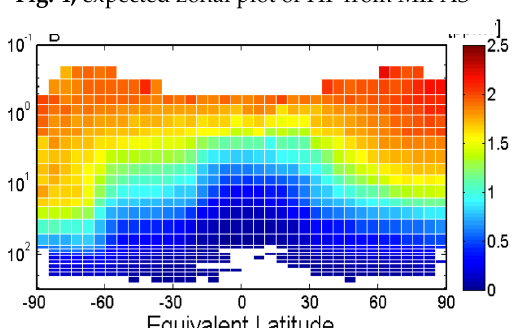
Fig. 4, expected zonal plot of HF from MIPAS